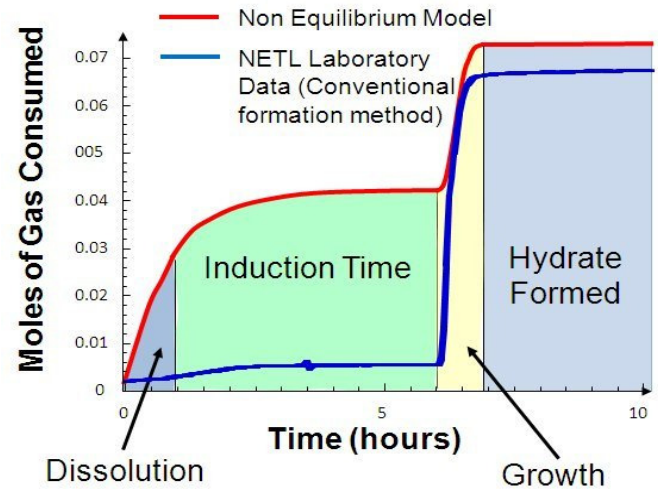
Figure 2. Non-equilibrium kinetic theoretical model approach to hydrate formation comparing model to laboratory data